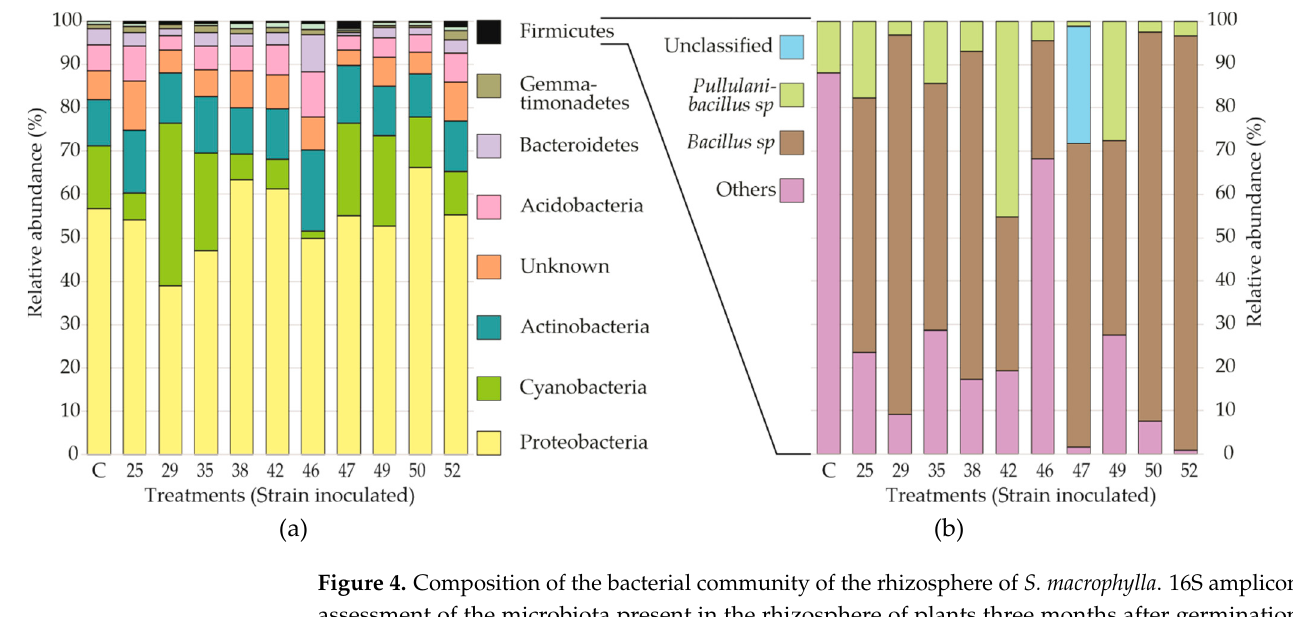
Figure 4 Composition of the bacterial community of the rhizosphere of S. macrophylla . 16S amplicon assessment of the microbiota present in the rhizosphere of plants three months after germination and inoculation with different rhizobacteria strains. Relative abundance (> 1%) and diversity of the primary bacterial strains in the rhizosphere at (a) Phylum or (b) Genus level graph showing only phylotypes belonging to the Firmicutes Phylum. The number in each treatment corresponds to the number of each strain. C letter refers to control treatment (non-inoculated).